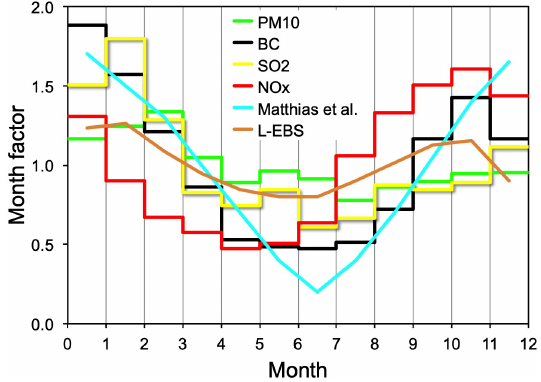
Figure 8. Month factors for emissions of PM 10 , BC, SO 2 , and NO x as determined by optimizing the agreement between EDGAR emis- sions and concentrations measured at the four stations in the present study. For comparison the month factors of Matthias et al. (2018) for combustion emissions are plotted, and the relative annual vari- ation of eBC concentrations measured at the station Leipzig Eisen- bahnstraße (L-EBS) are averaged over the time period of the present